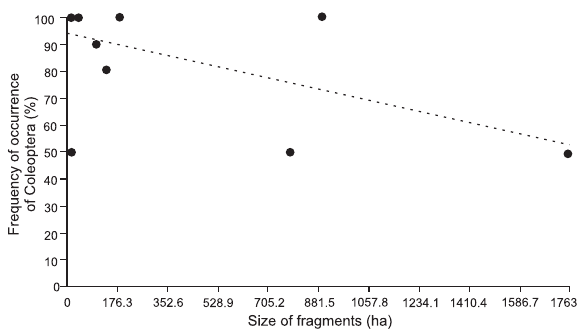
Figure 4. Linear regression showing the influence of forest frag- ment size on the frequency of occurrence of Coleoptera.